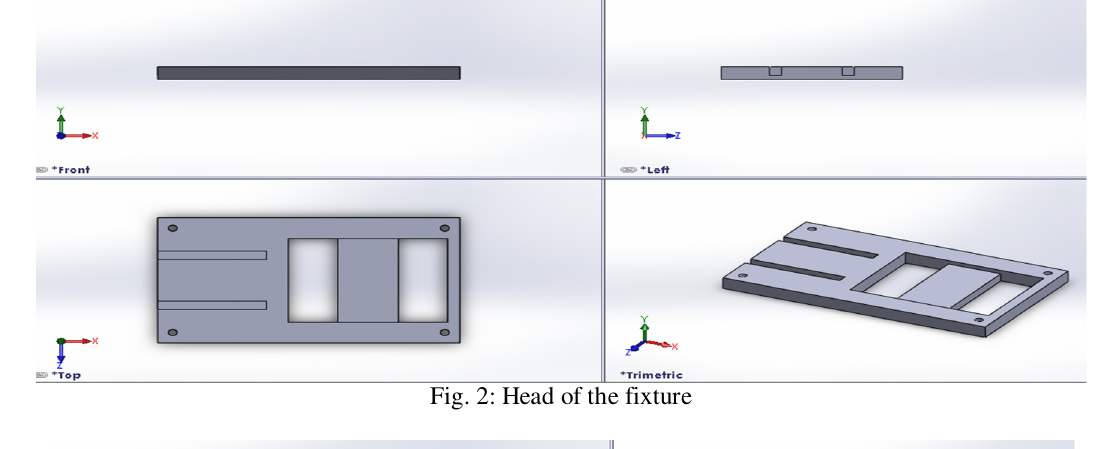
Fig. 2: Head of the fixture